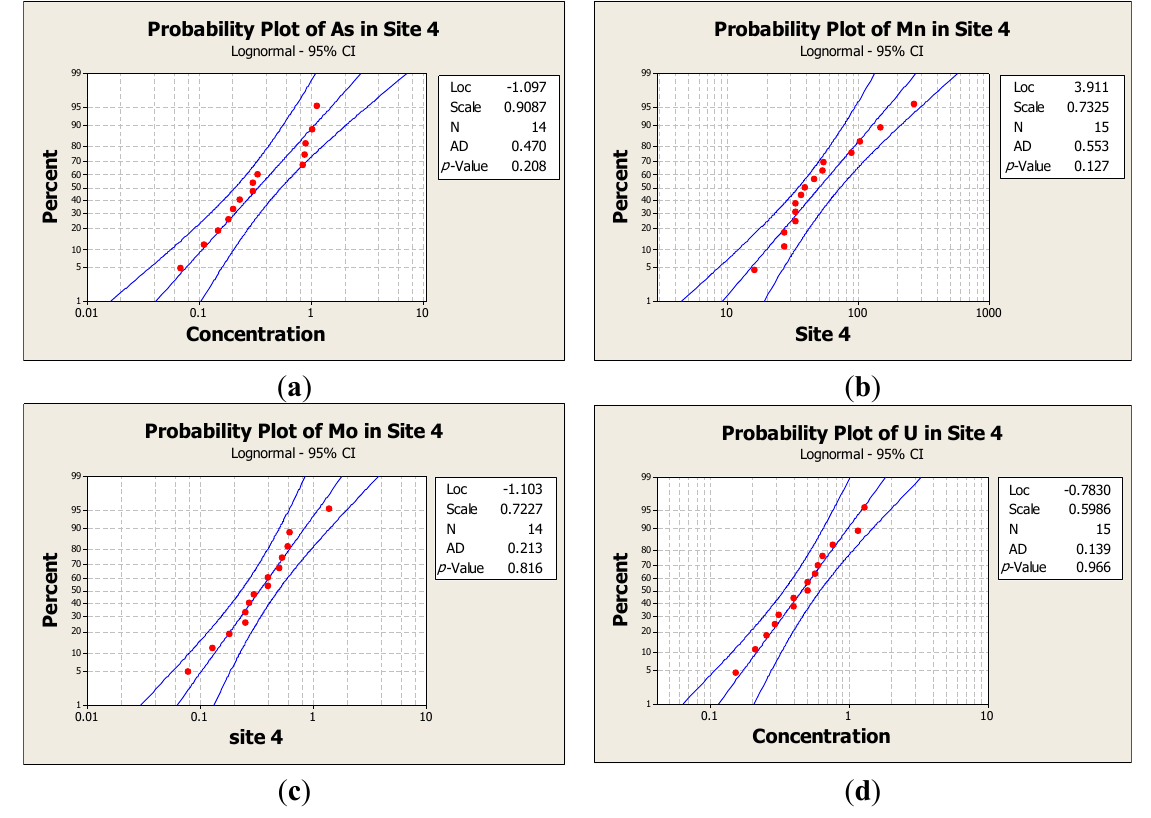
Figure 4. Probability test plots for a concentration of ( a ) As; ( b ) Mn; ( c ) Mo; ( d ) U; and ( e )